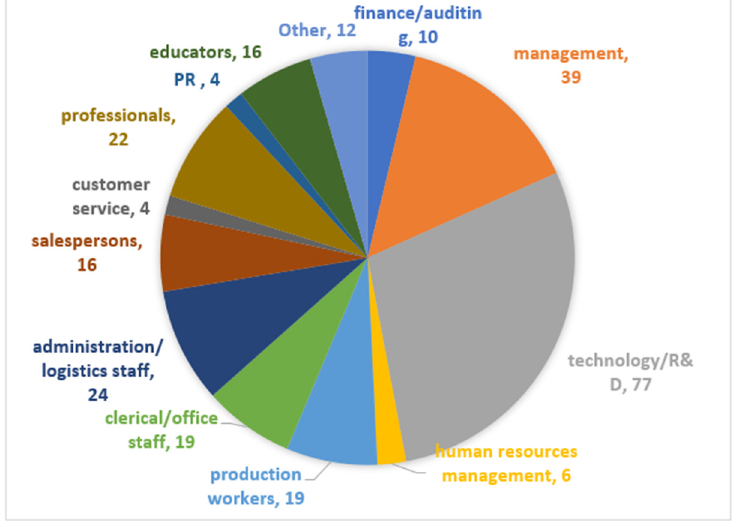
Figure 5. Distribution of occupation (numbers in figure represent an actual number of test subjects in each group).